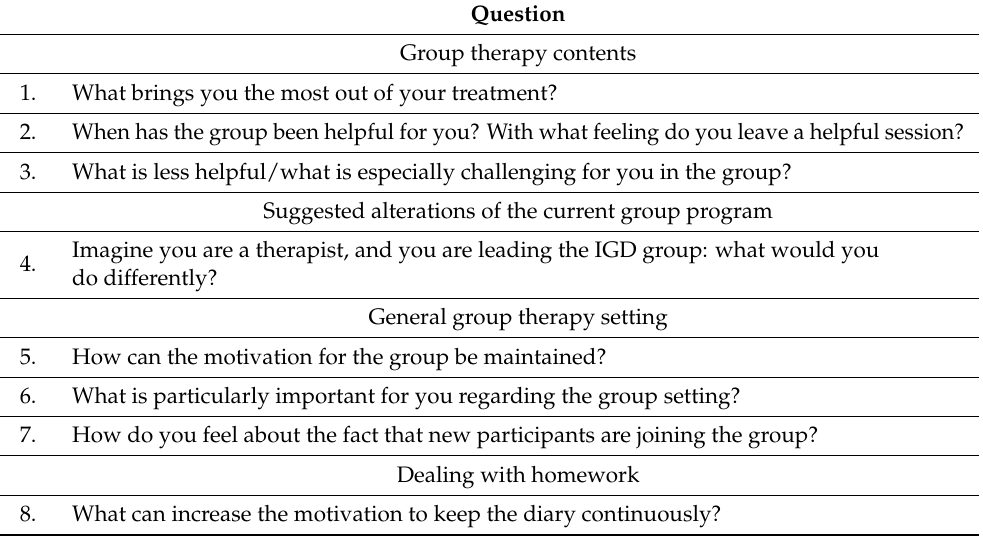
Table 2. Extracts from the patient interview guide (translation by the